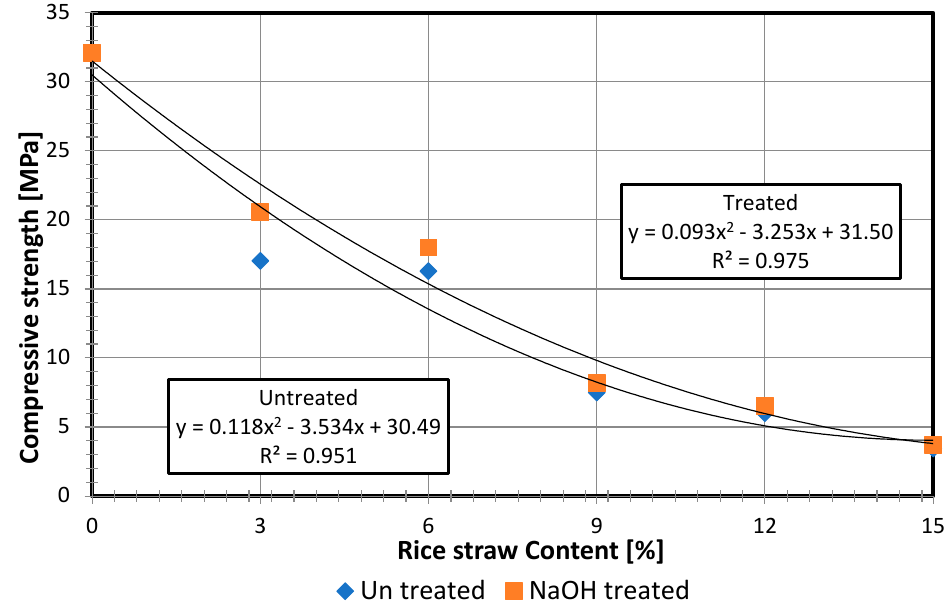
Figure 7. Compressive strength of the treated and untreated rice straw concrete at different rice straw